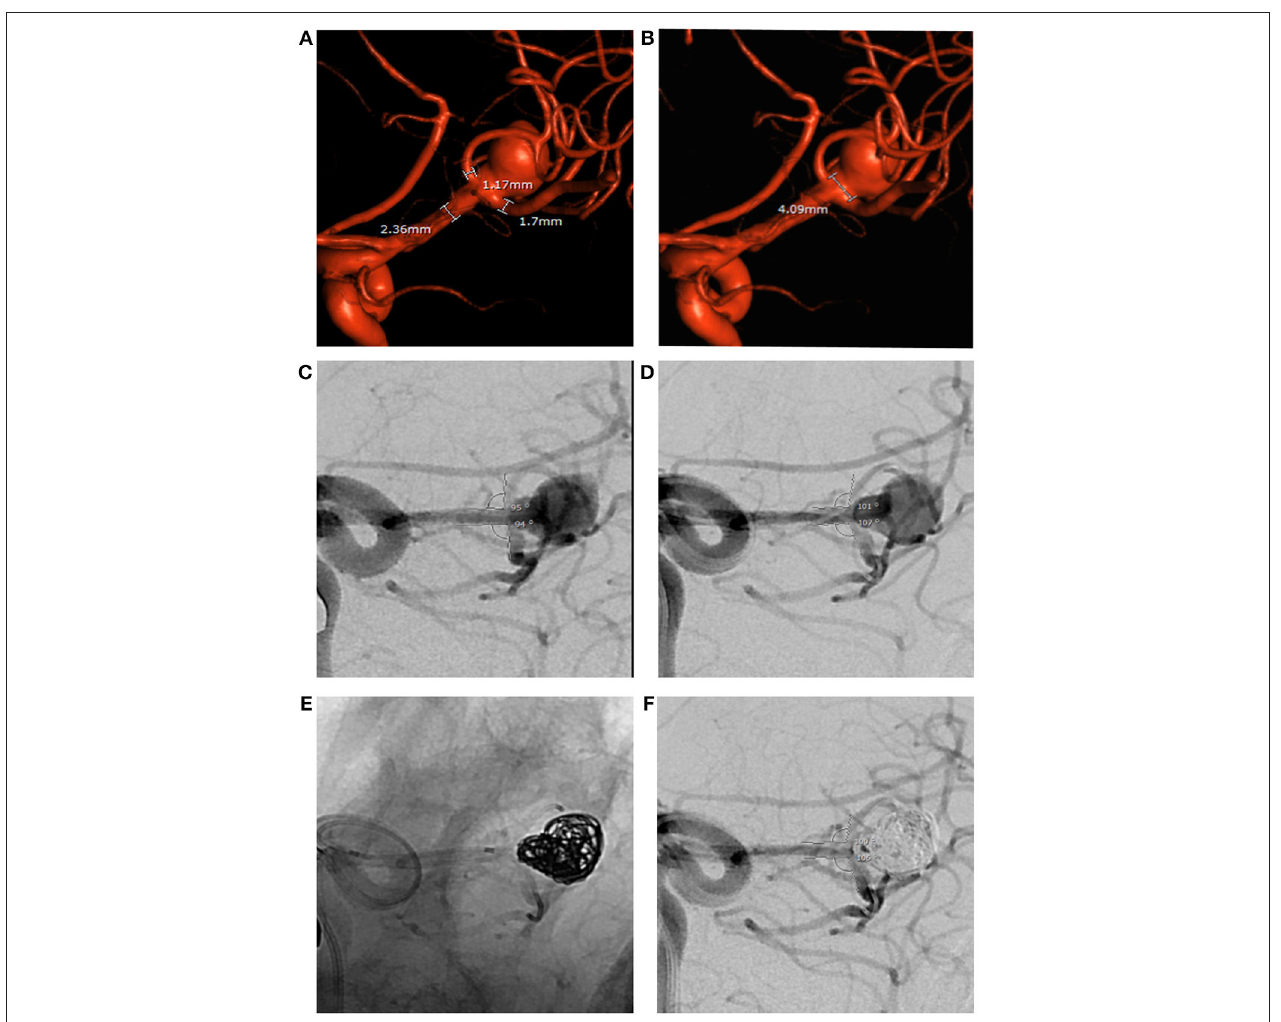
FIGURE 3 | Large ruptured middle cerebral artery bifurcation aneurysm treated by PTN in 2018. (A,B) Pre-op 3D angiography: wide aneurysm neck, parent and branch vessel diameters below minimum limits for both PulseRider Aneurysn Neck Reconstruction Device and all HDE stents. (C,D) Bifurcation branch angles in working view. (E,F) Change in bifurcation branch angles after placement of a microcatheter in each branch persists during aneurysm